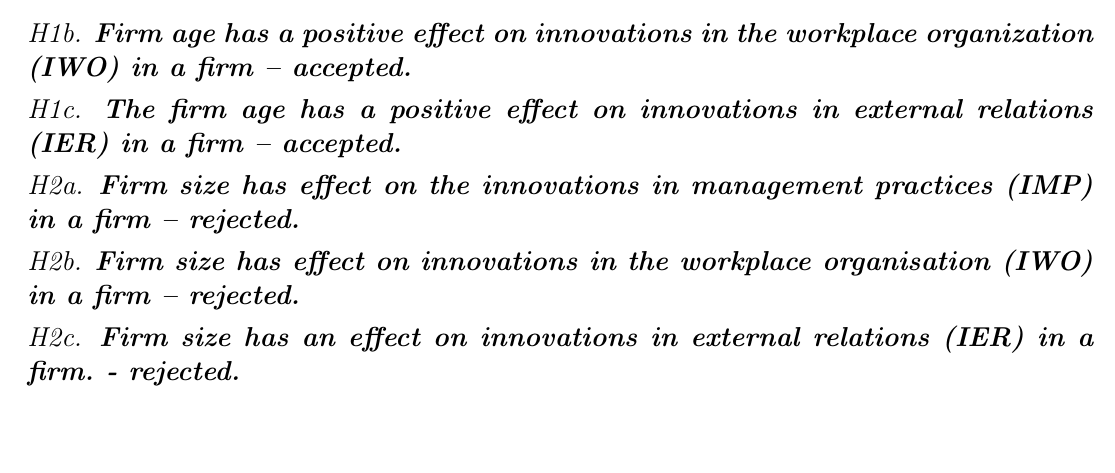
Table 2. Results of the correlation and regression analysis.